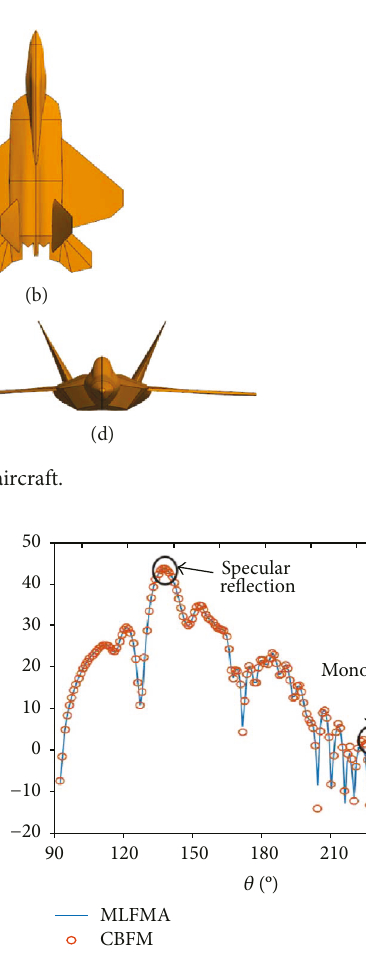
Figure 2: Bistatic RCS of an